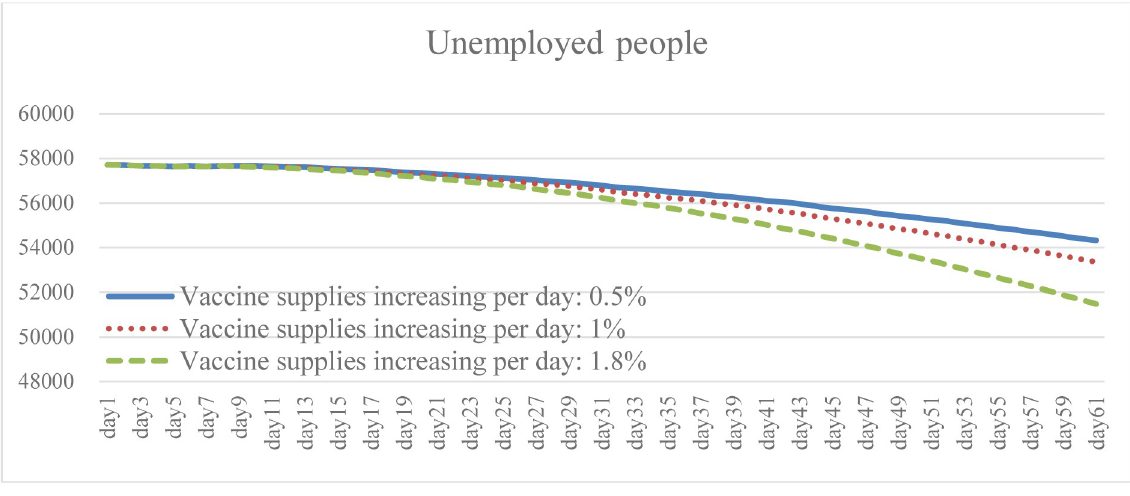
Fig 15. Unemployed peple under different vaccine